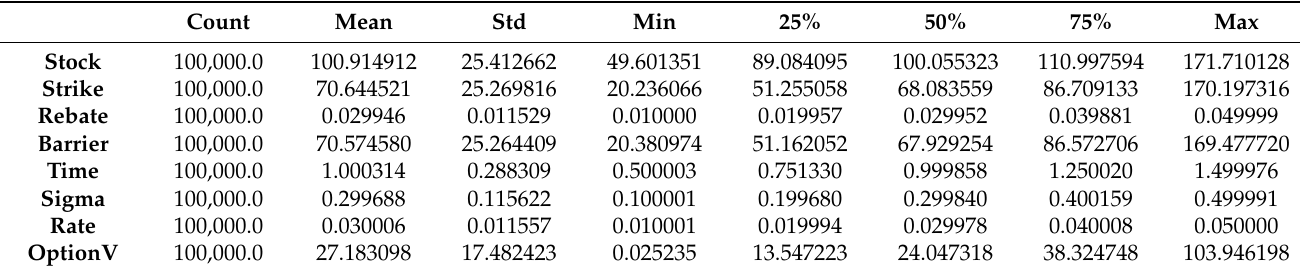
Table 5. Descriptive statistics for the rebate